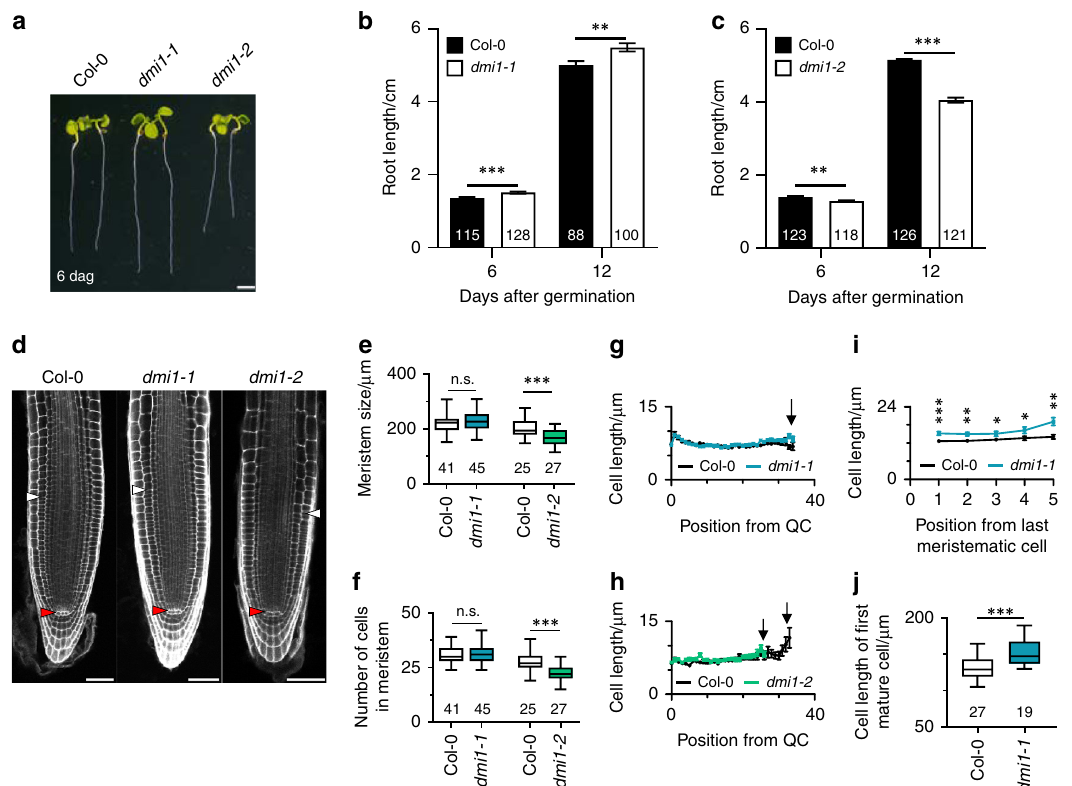
Fig. 1 dmi1 mutants are impaired in primary root development. a Representative image of Col-0, dmi1-1 , and dmi1-2 seedlings 6 days after germination (dag) (scale bar represents 0.2 cm). b , c Primary root length of wild type (Col-0), dmi1-1 ( b ) and dmi1-2 ( c ) 6 and 12 dag. d Cellular organisation of the root meristem visualised by confocal microscopy after staining with propidium iodide of wild type (Col-0), dmi1-1 , and dmi1-2 at 6 dag. White and red triangles mark the fi rst elongated cortex cell and the quiescent centre (QC), respectively. Scale bars represent 50 µ m. e – h Root meristem length ( e ), root meristem cell number ( f ), and cell length over cell position from the QC to the last meristematic cortex cell ( g , h ) of wild type (Col-0), dmi1-1 , and dmi1-2 . Black arrows in g , h mark the last meristematic cell. i Cell length over cell position from the fi rst rapidly elongated cortex cell of Col-0 and dmi1-1 . ( n ≥ 41 in each population for each cell position) . j Cell length of the fi rst mature cortex cell of Col-0 and dmi1-1 . Values in bar and xy charts are means ± s.e.m. Box and whisker plots show 25% and 75% percentiles, median, minimum, and maximum. Numbers in bars and under boxes denote sample size ( n ). n.s. not signi fi cant, * p < 0.05, ** p < 0.01, *** p < 0.001 (two-tailed t test with a prior F -test for homoscedasticity). b , c , e – i The data represent three biological replicates. j The data represent two biological replicates